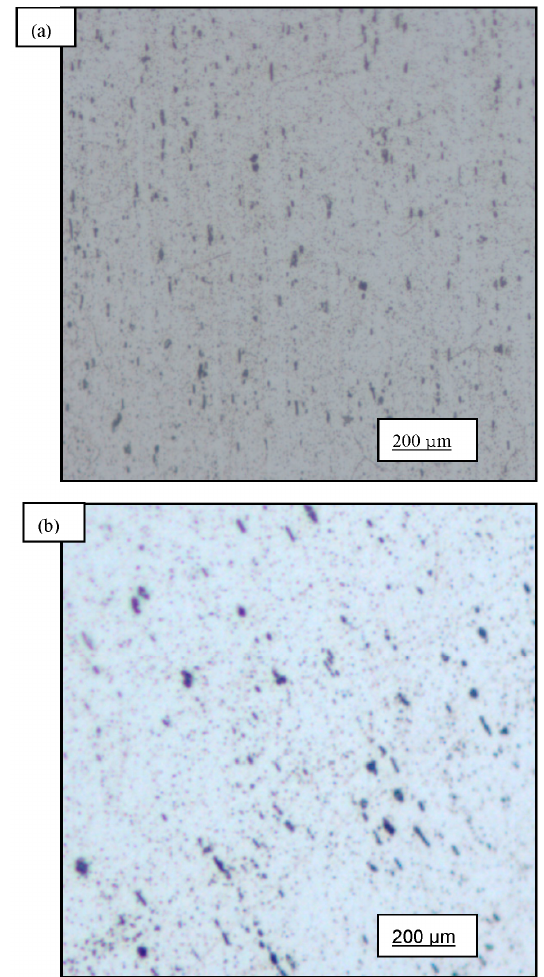
Figure 3. Light optical micrographs of aluminum alloy 6061-T4 showing microstructure the following: ( a ) Coarse and intermediate second phase particles in the base metal of the as-received or as-provided metal; ( b ) distribution of intermetallic particles in the heat-treated sample.